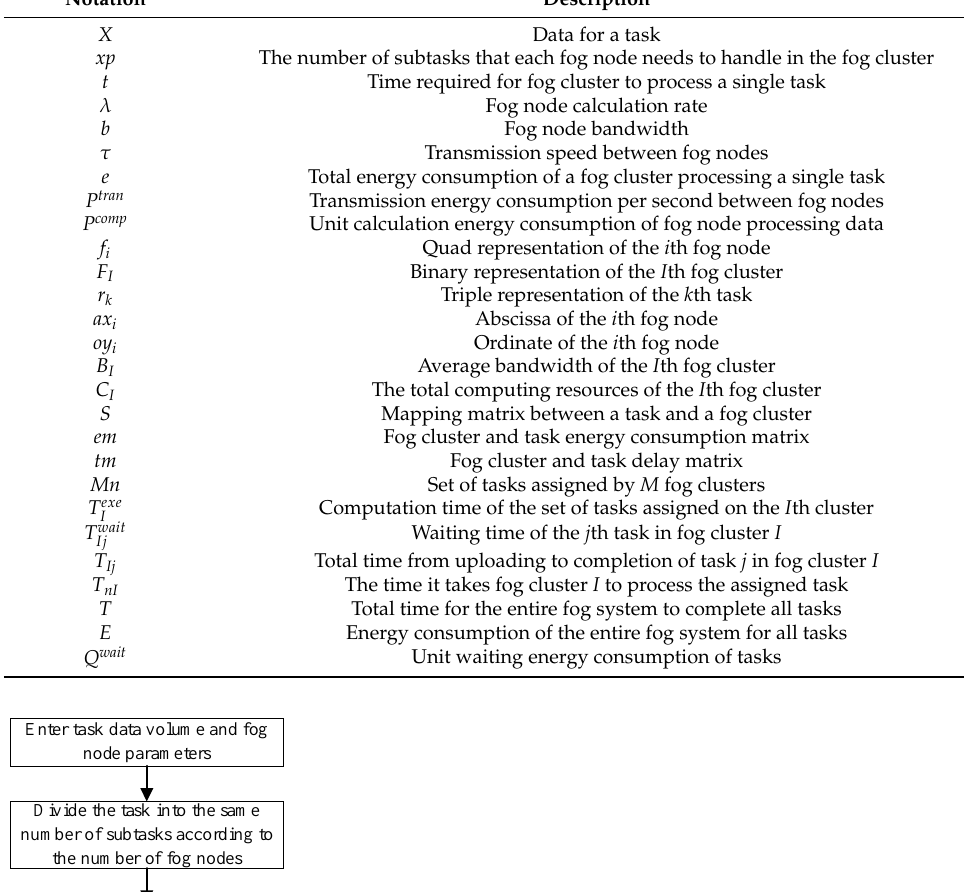
Figure 2. Load-balancing process.